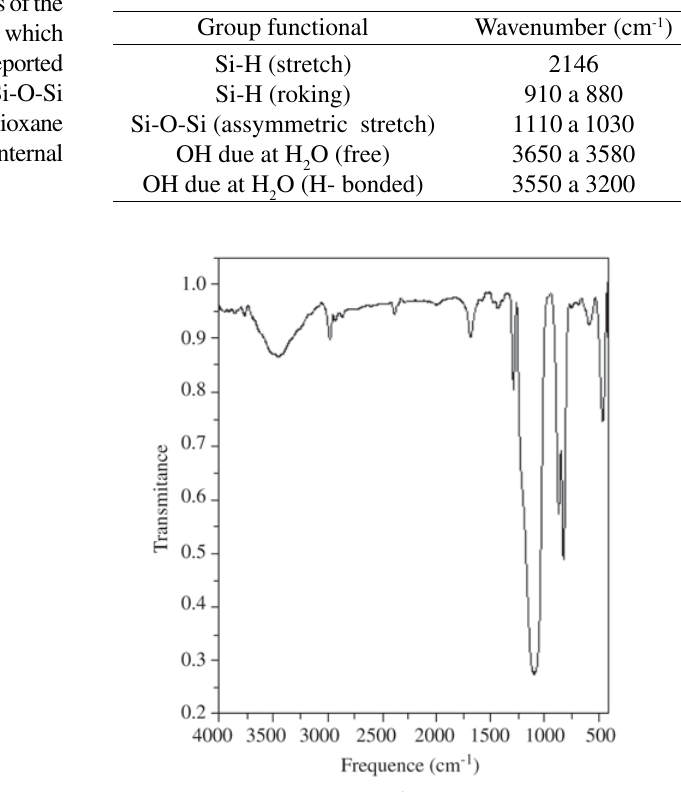
Table 1. Selected vibration frequencies for